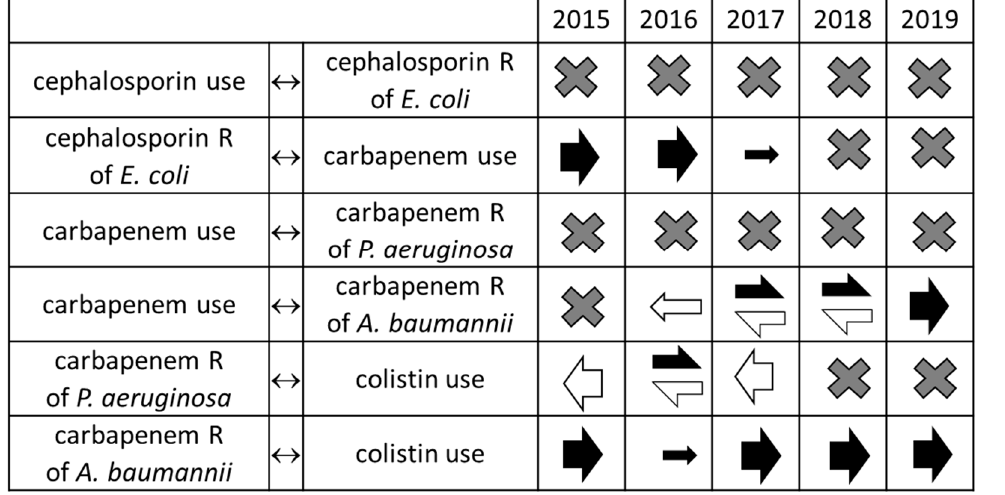
Figure 4. Relationships between antibiotic use and resistance in the model containing the whole resistance spiral. Shaded cells show relationships proved to be unimportant in the species-by-species models and, therefore, not included in the model of the spiral. X symbol: no significant relationship; filled arrows: positive relationship (effect on response is directly proportionate to the impulse), open arrows: negative relationship (effect on response is inversely proportionate to the impulse), directions of arrows show the direction of the relationship, i.e., arrows pointing right show that the left variable is the impulse and the right variable is the response, arrows pointing left mark the